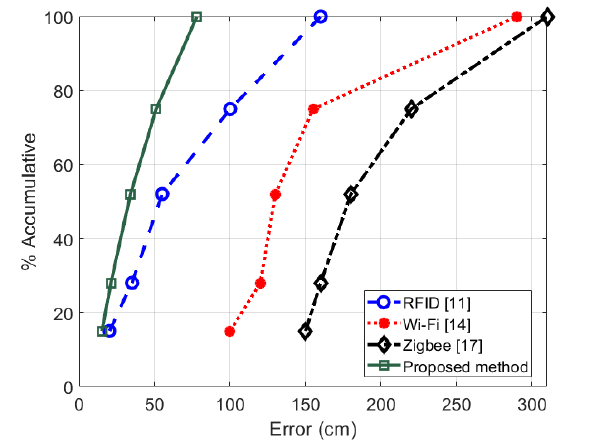
Figure 6. Performance comparison of the proposed system and traditional radio frequency technologies in terms of the localization estimation error. Radio Frequency IDentification (RFID), Wireless Fidelity